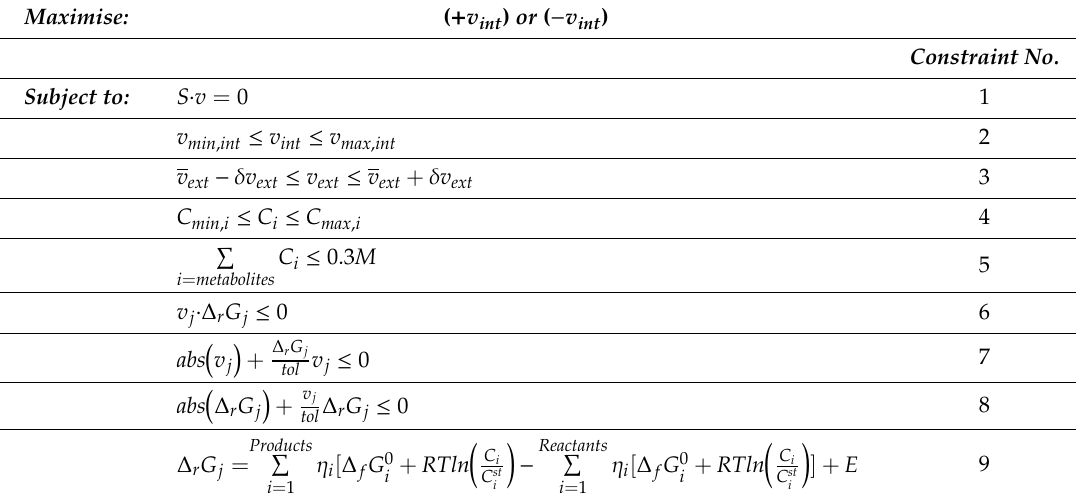
Table 2. List of constraints used in (TBFE) to probe the upper and lower flux limits of all thermodynamically feasible